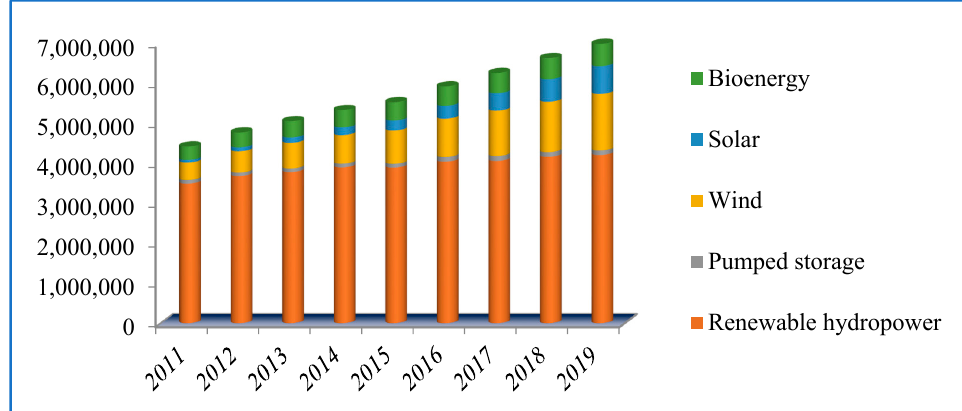
Figure 11. Worldwide renewable electricity generation (MW) statistics.